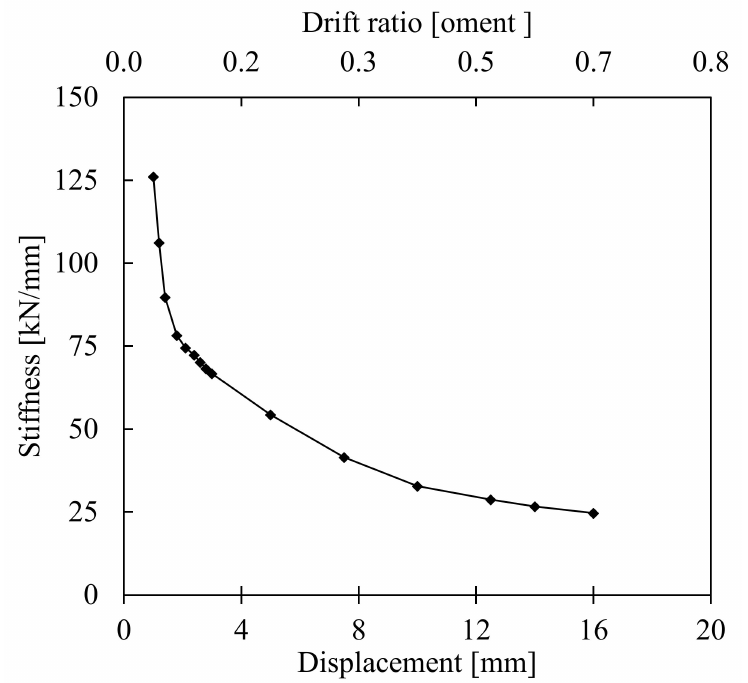
Figure 28. Stiffness versus displacement curve of the tested PCSP-ISF